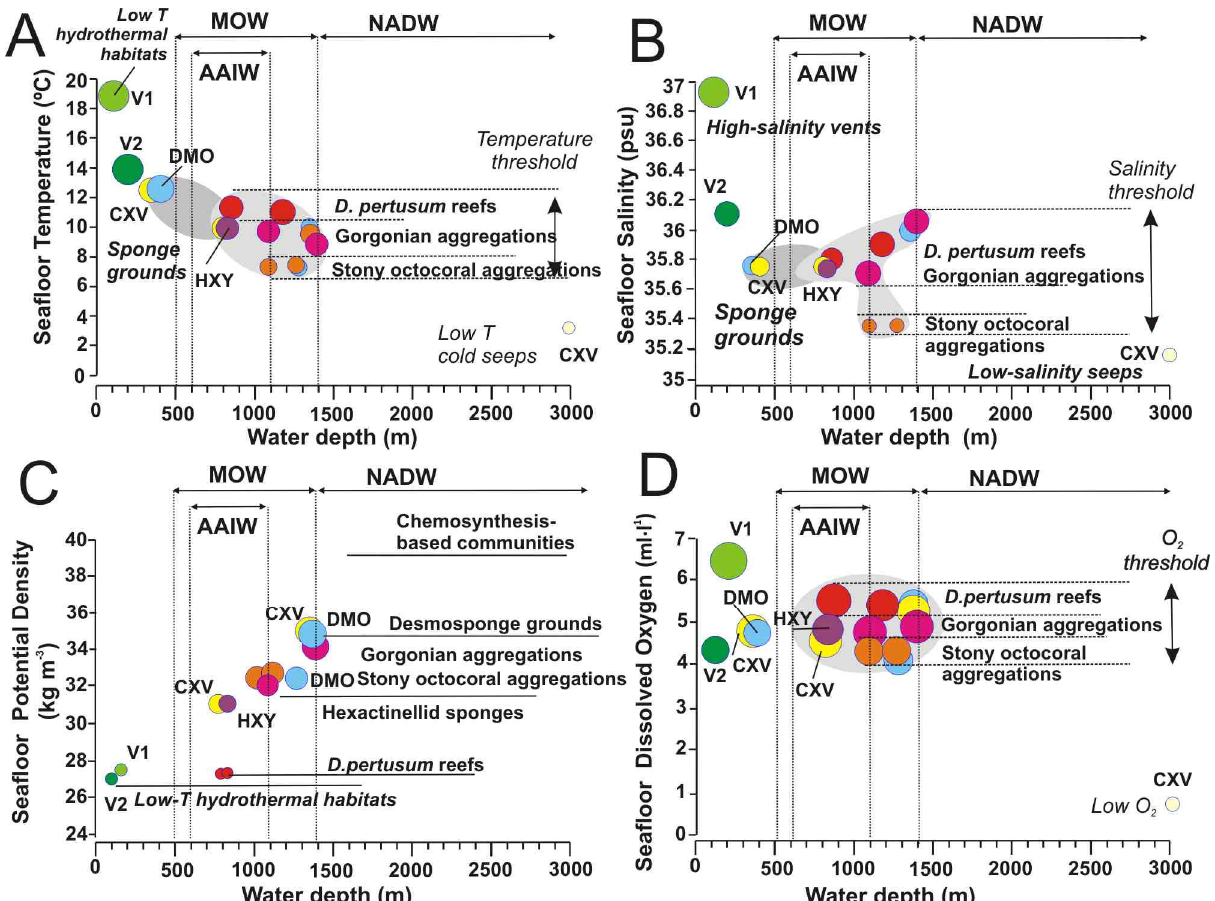
Figure 14. Seafloor water mass parameters vs. water depths for each of the identified vulnerable deep-sea habitats and their exposure to the main bottom currents: ( A ) Temperature; ( B ) Salinity; ( C ) Potential Density, and ( D ) Dissolved Oxygen. Color legend for deep-sea habitat types is the same as Figure 13. AAIW: Antarctic Intermediate Water current; MOW: Mediterranean Outflow Water; NADW: North Atlantic Deep-Water current. Data are full listed in Supplementary Table S3. Further explanation in the text.